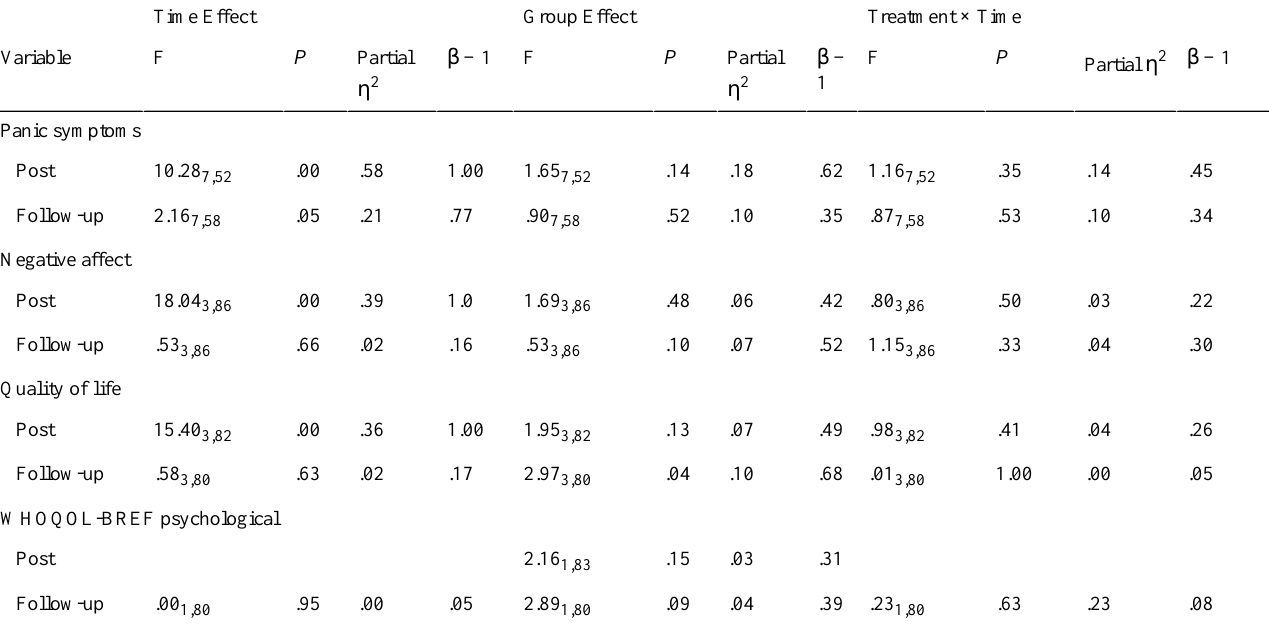
Table 7. Effects from the repeated measures MANOVA and ANCOVA analysis between